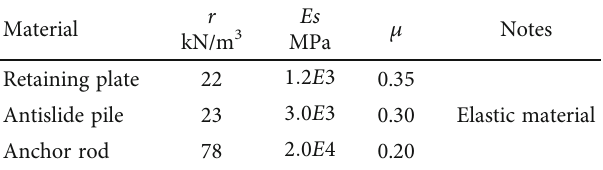
Figure 8: Distribution of axial force of the anchor cable against the pile top displacement. Table 3: Physical and mechanical parameters of model materials. Material